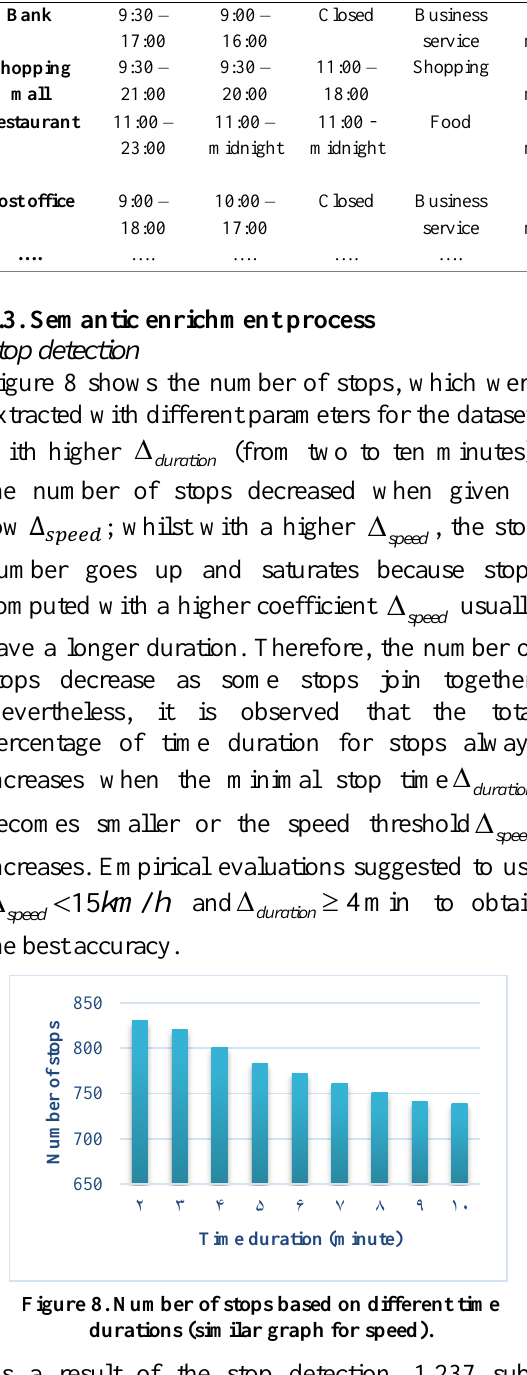
Figure 10. All detected stops in different land use